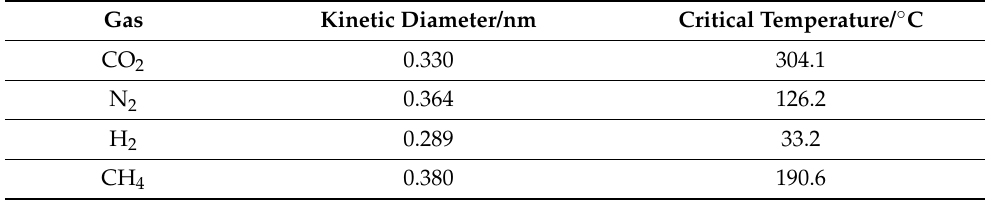
Table 1. Physical properties of different gases